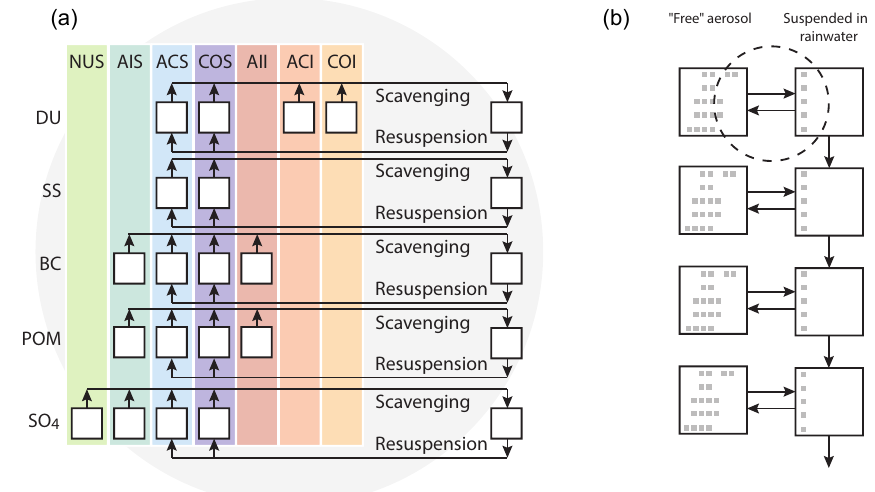
Figure 3. (a) Close-up of the transfer between 18 mass tracers in M7 and suspended aerosol tracers. Abbreviations stand for M7 modes. The first two letters refer to mode size and the last to mode solubility; e.g. ACS is the soluble accumulation mode. Note that bulk aerosol species are not divided over multiple tracers and therefore do not need aggregation in the deposition scheme. (b) Overview of the new wet deposition scheme when number processing is applied. The atmospheric “free aerosol” tracers of M7 and the new wet diagnostic deposition scheme with five aggregated tracers (grey dots) are transferred by scavenging and resuspension (arrows) on each level.